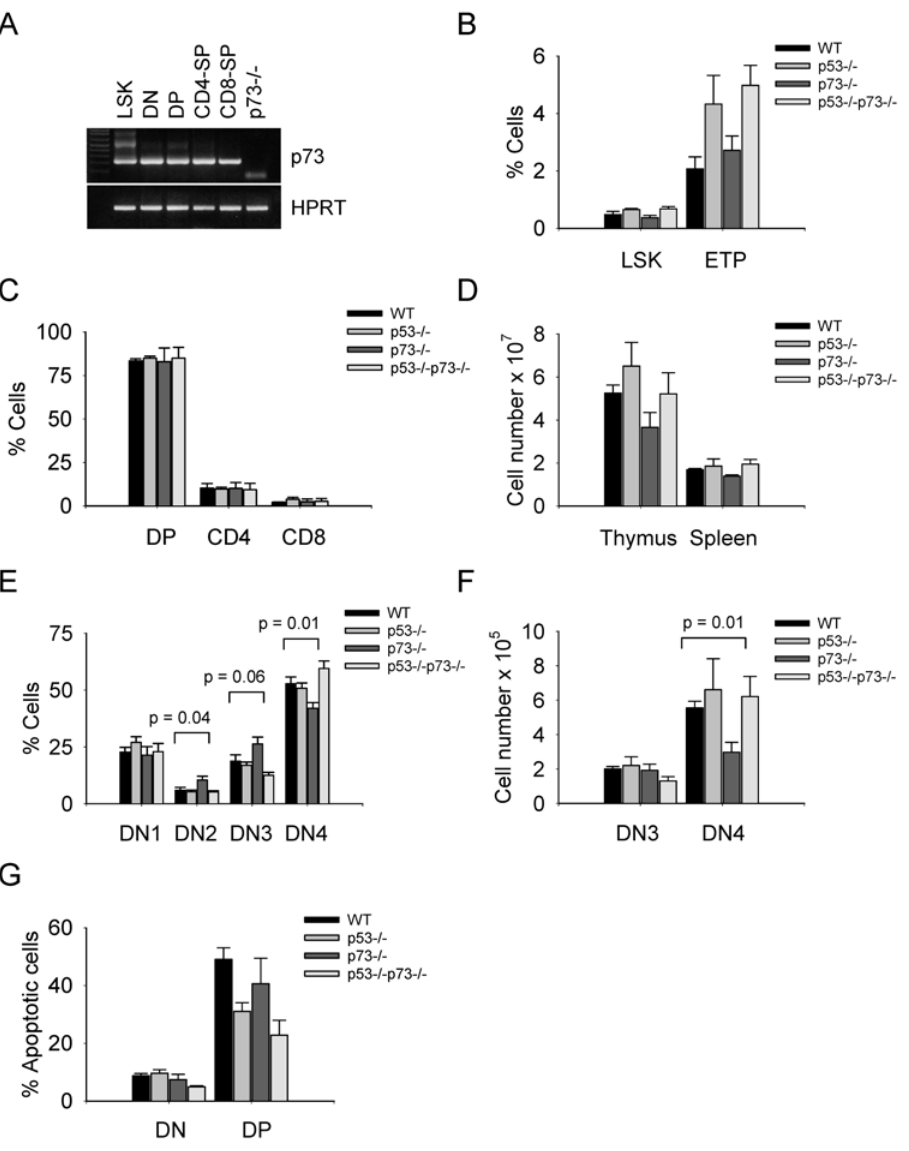
Figure 4. Inactivation of p73 causes defects in T cell development. A. Semi-quantitative RT-PCR analysis of p73 mRNA levels in sorted bone marrow Lin-Sca1 + c-Kit + (LSK) cells, thymic CD4/CD8 double negative (DN), CD4/CD8 double positive (DP), CD4-SP and CD8-SP cells from WT mice. HPRT is a control for equal input. p73 2 / 2 thymocytes are shown for control. B. The frequency of LSK lymphoid progenitors in bone marrow and early T lineage progenitors (ETP) in thymi of mice of the indicated genotypes. ETP cells represent a c-Kit-positive subset of the DN1 (CD44 + CD25-) population. The error bars represent the standard error obtained from six experiments. C. Relative numbers of DP, CD4-SP and CD8-SP T cell in thymi from 4-week old mice of the indicated genotypes. The error bars represent the standard error. D. Total cell numbers in thymi and spleens of 4 week- old mice of the indicated genotypes. The error bars represent the standard error obtained from six experiments. E, F. Thymocytes from 4-week old mice of the indicated genotypes were stained with antibodies to CD4, CD8, CD25 and CD44. Gating on CD4/CD8 double negative cells. Relative numbers of DN1-4 ( E ) and absolute numbers of DN3/DN4 subsets ( F ) are indicated. The error bars represent the standard error obtained from eight experiments. P-values for the difference between WT and p73 2 / 2 subsets are shown. G. Annexin V staining of DN and DP thymocytes from 4 week- old mice of the indicated genotypes. The error bars represent the standard error obtained from three experiments.